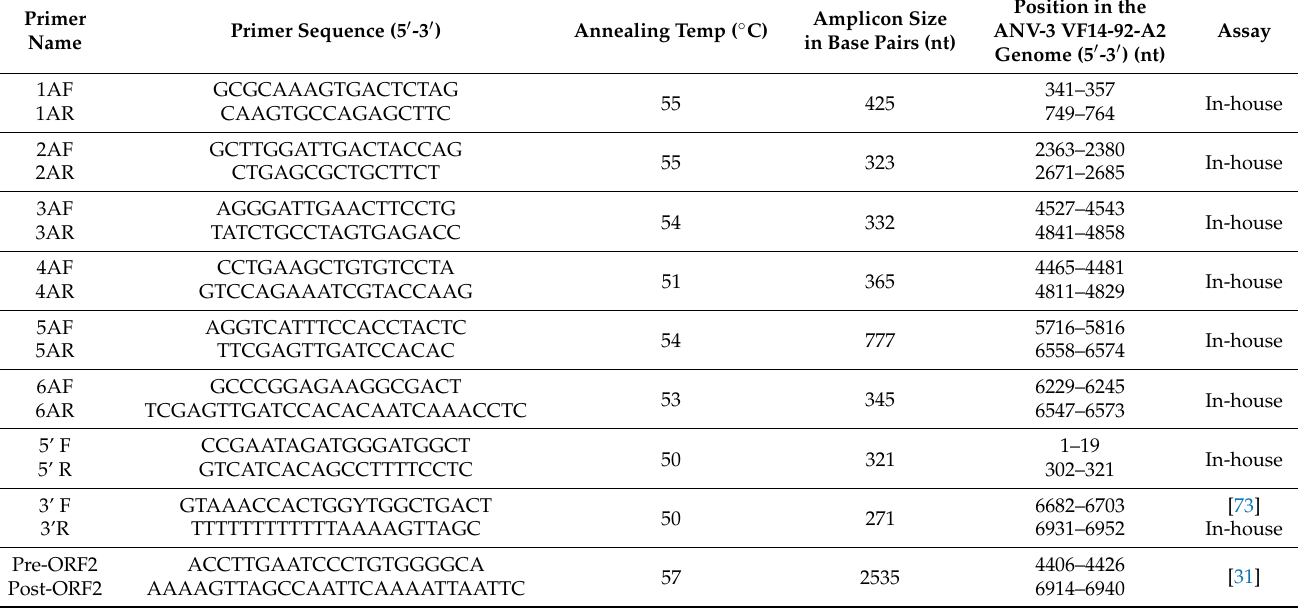
Table 1. Avian nephritis virus (ANV) primer sequence specifications. Sanger sequencing primers for patch sequencing of MT585643